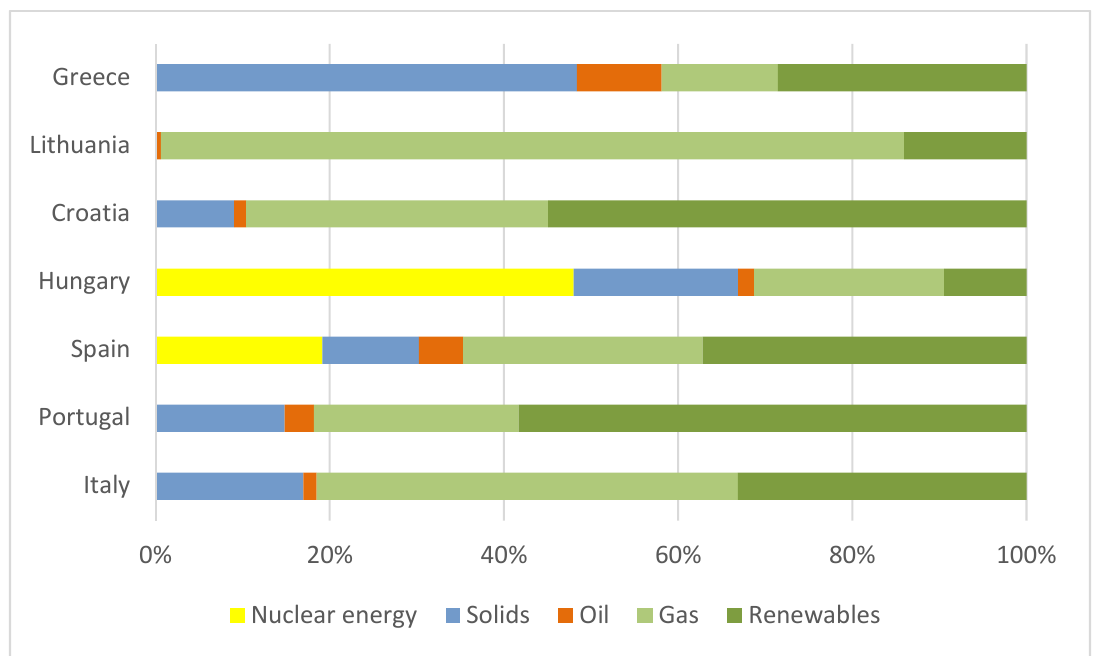
Figure 9. Structure of energy mixes for the fourth cluster. Source (own elaboration).